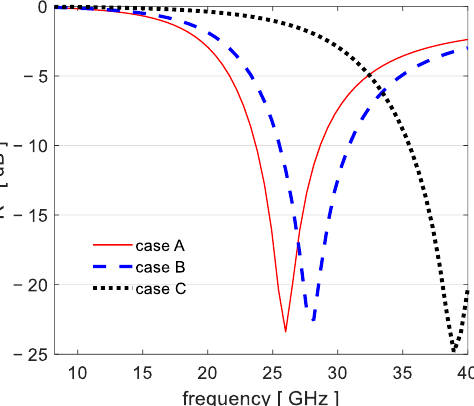
Figure 10. Frequency spectra of the reflection coefficient for the cases A,B and C shown in Table 3 for normal incidence.